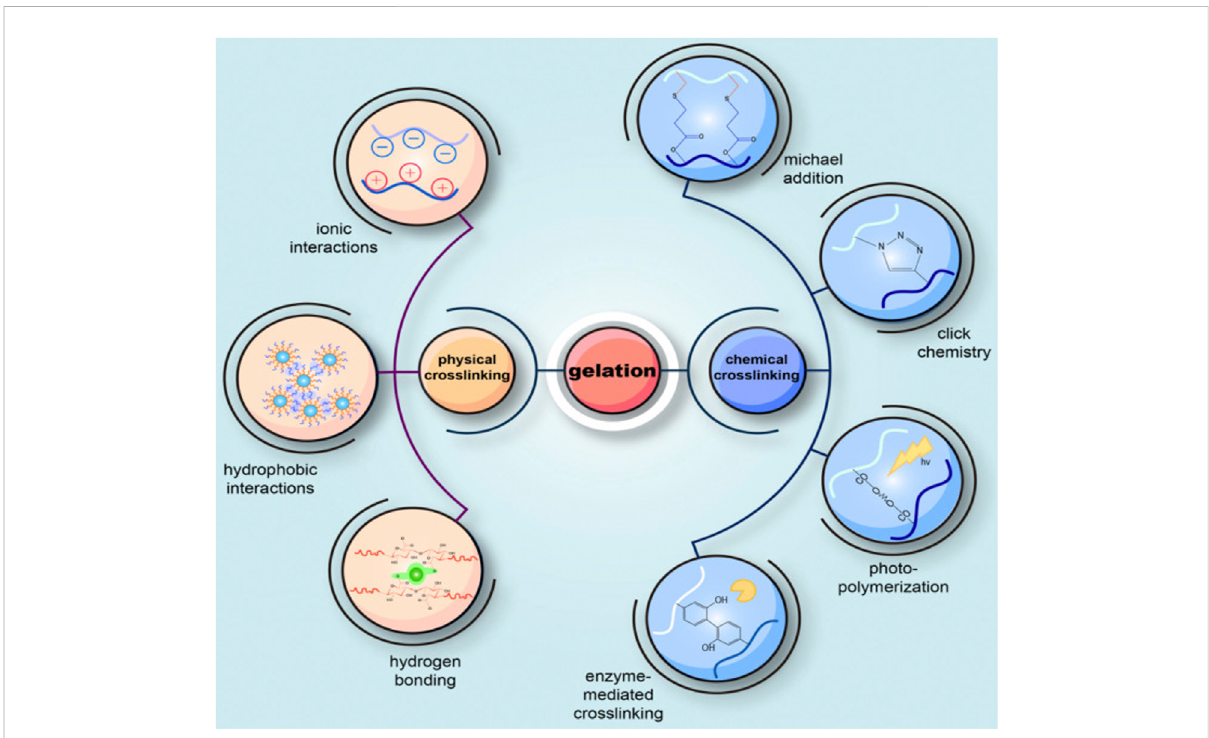
FIGURE 2 Schematicdiagramofcommon methodsfor preparing injectable hydrogels. Injectablehydrogelscanberoughly dividedinto twogelmethods: physical cross-linking and chemical cross-linking reactions. The difference between them is whether or not covalent bonds are formed. Physical cross-linking is non-covalent bonding via reversible and instantaneous connections, including physicochemical or molecular entanglement interactions (hydrogen bonding, ionic or hydrophobic interactions). Chemical cross-linking forms covalent bonds in various chemical processes, including enzyme-mediated cross-linking, photopolymerization, click chemistry, Michael ’ s addition, Schiff base chemistry, and cross- linking agents. Adapted with permission of Wu et al.